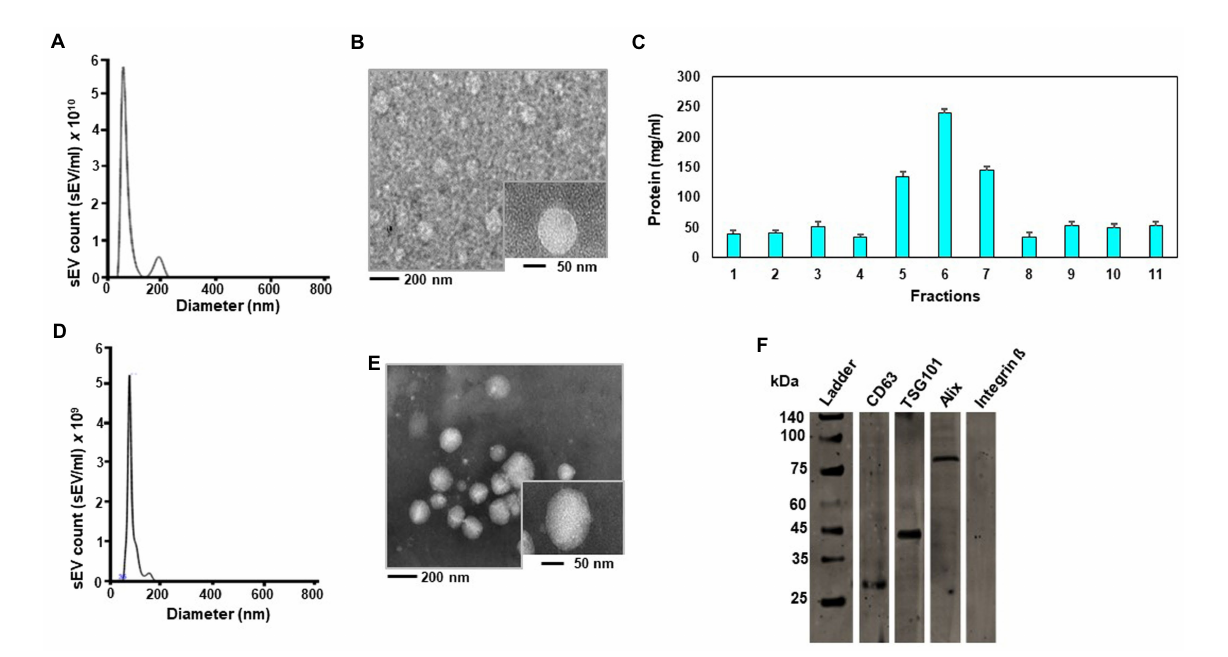
FIGURE 1 Authentication of small extracellular vesicles (sEVs) from chicken egg yolk. Size distribution of sEVs isolated by ultracentrifugation without subsequent iodixanol gradient centrifugation analyzed in a Nanosight NS300 instrument (A) . Transmission electron microscope (TEM) image of sEV suspension isolated by ultracentrifugation without subsequent iodixanol gradient centrifugation. The large-field image was obtained at 20,000-fold magnification and the insert depicts an sEV at 50,000-fold magnification (B) . Protein concentration in iodixanol gradient fractions (C) . Size distribution of sEVs in iodixanol gradient fraction 6 (D) . TEM image of sEVs in iodixanol gradient fraction 6. The large-field image was obtained at 20,000-fold magnification and the insert depicts an sEV at 50,000-fold magnification (E) . Immunoblot of chicken egg sEVs in iodixanol gradient fraction 6. Samples were run on the same gel. Lanes were cut for probing with antibodies and electronically re-assembled. Proteins were detected as follows: CD63 at 26 kDa, TSG101 at 44 kDa, Alix at 96 kDa and no Integrin ᵝ at 130 kDa (F)